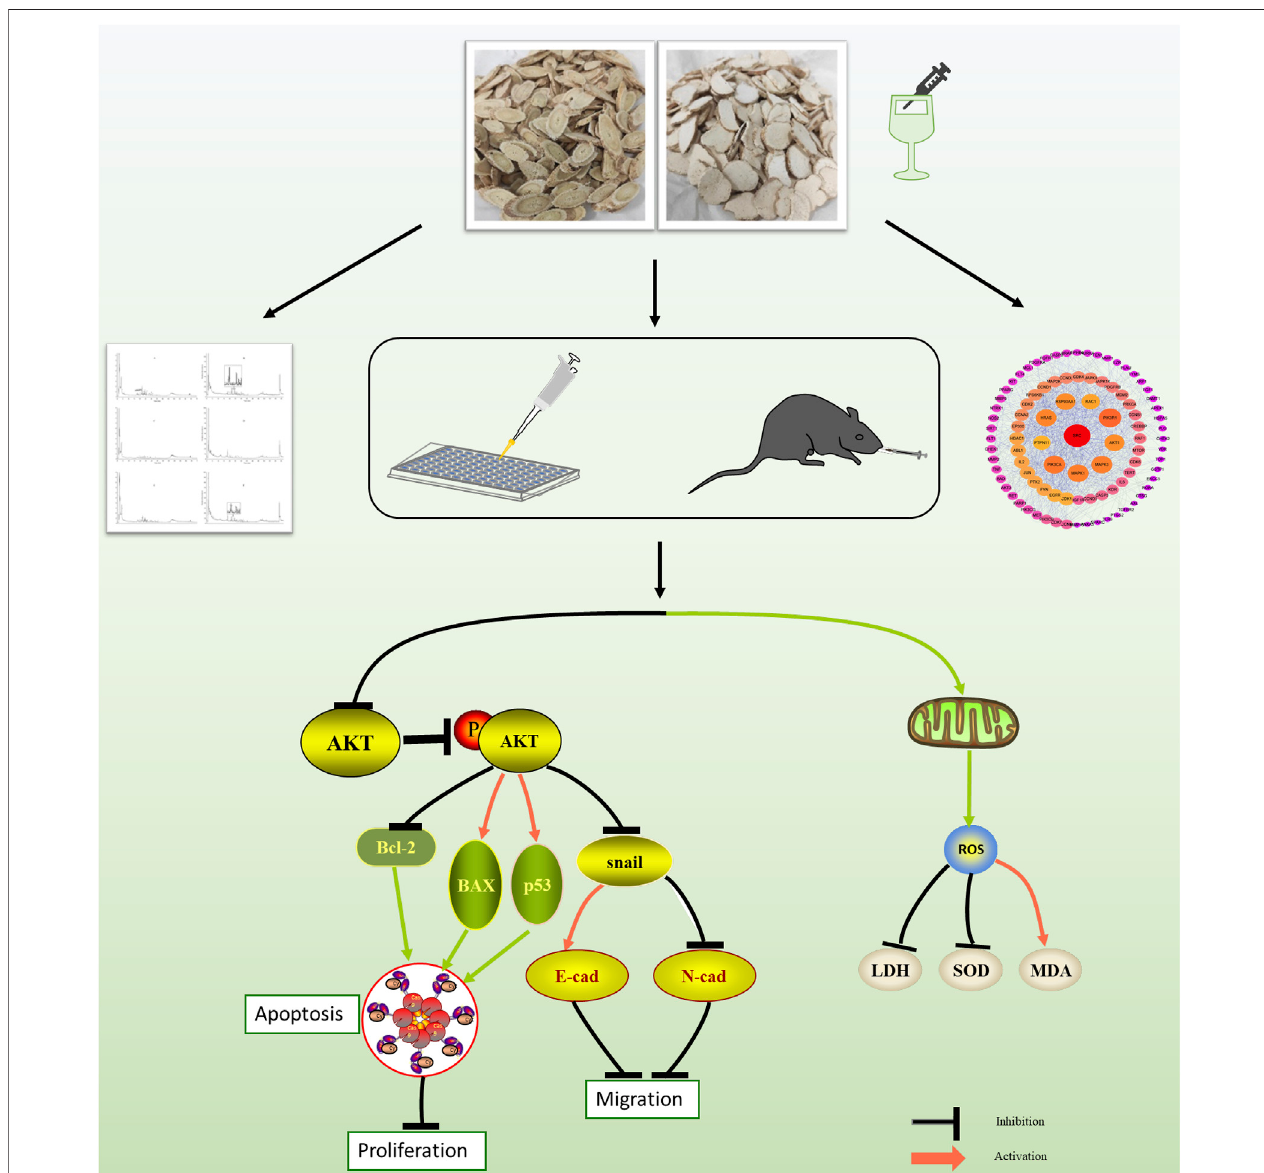
FIGURE 10 | Progress of this study and the effects of AMD, RTD, and their “ cocktail ” on the Akt-related signaling pathway in vitro and in vivo .